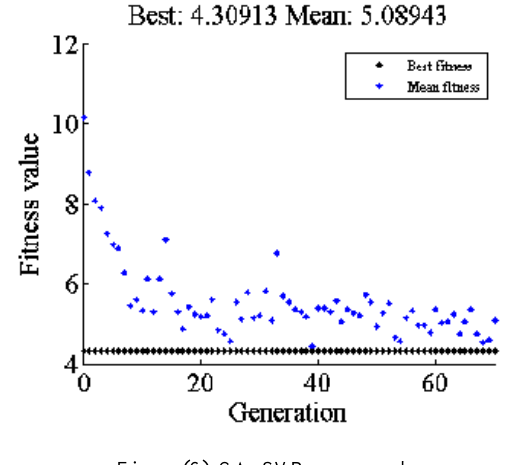
Figure (5) show the convergence of the model. Table (2) show the MSE, RMSE, Normalized RMSE and R-square for train and test data set at the end the model that Obtained from previous phases has been apply on the mentioned region and SD model was obtained Figure